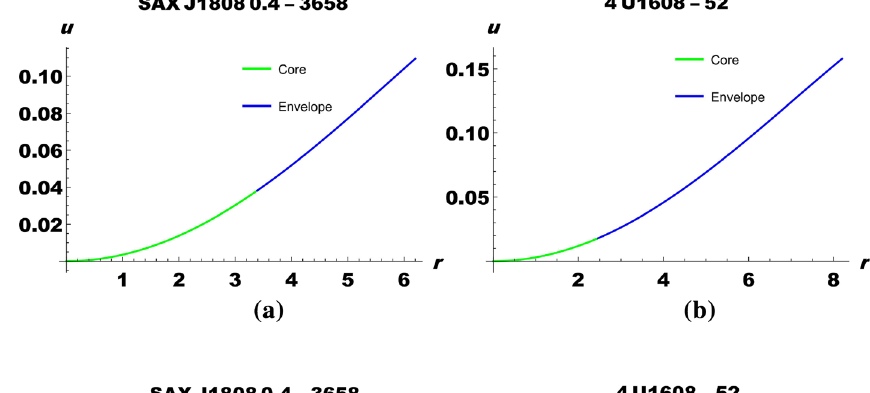
Fig. 8 Variation of anisotropy with radial